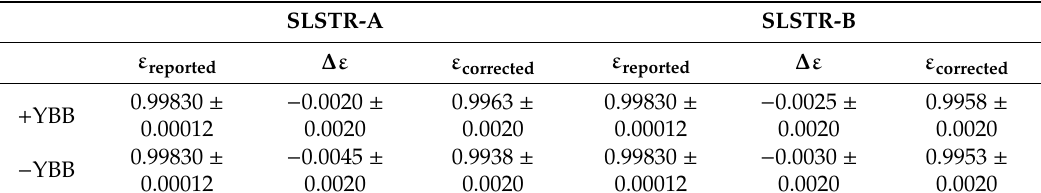
Table 9. Original and corrected on-board BB emissivities for channel S7. Uncertainty estimates for the error are derived from the fit to the measurements.